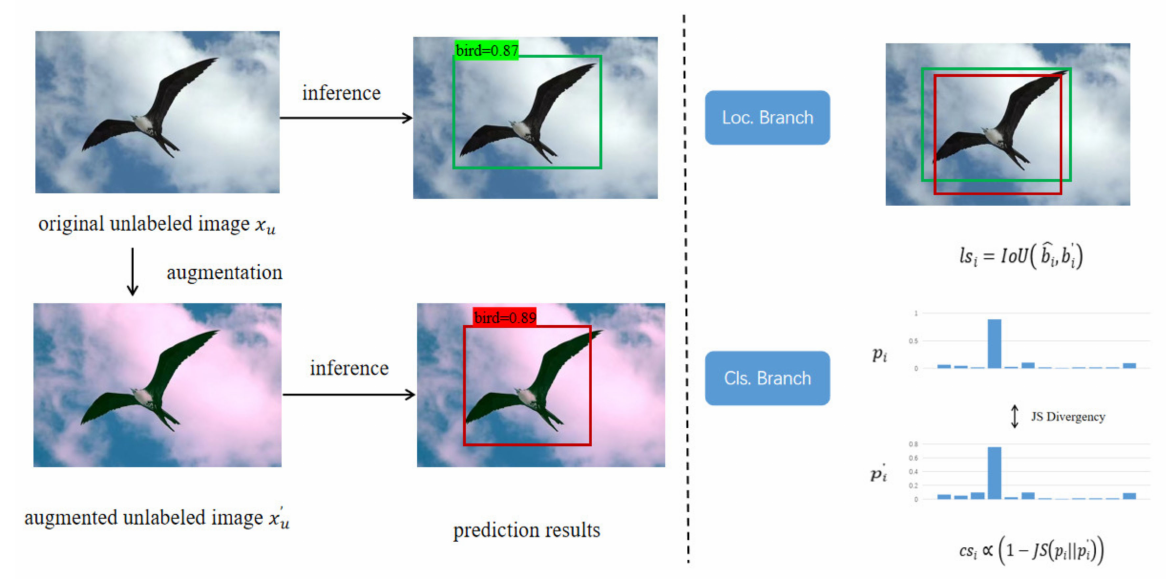
Figure 2. Localization and classification stability calculation